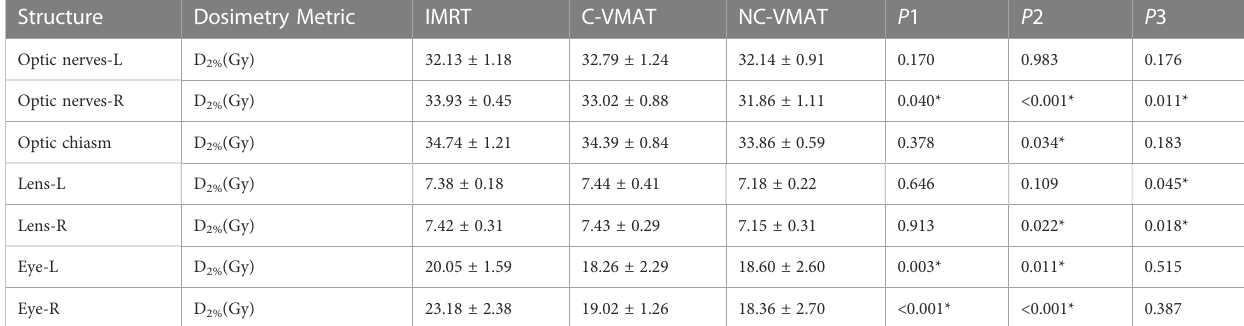
TABLE 7 The dosimetric values (mean ± SD) of other OARs under three types of treatments (IMRT, C-VMAT and NC-VMAT) and comparison of the three treatments in terms of dosimetry metric and related p values. Structure